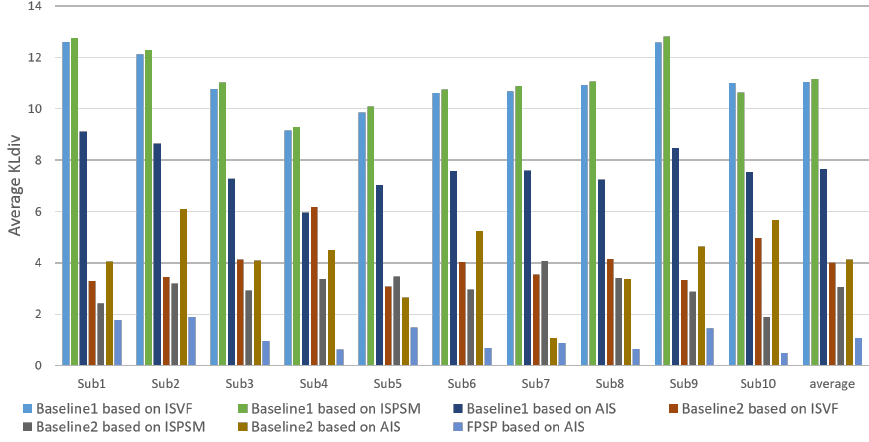
Figure 11. Average KLdiv of each target person ( ↓ ) with comparison to PSM prediction